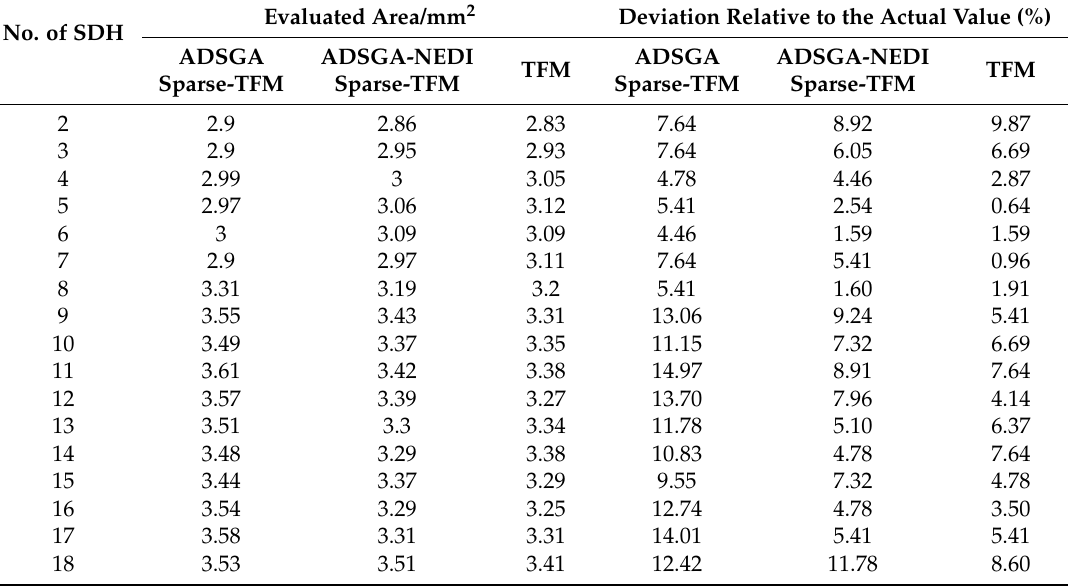
Table 2. Measurement results of the defect holes using different methods. Evaluated Area/mm 2 Deviation Relative to the Actual Value No. of SDH